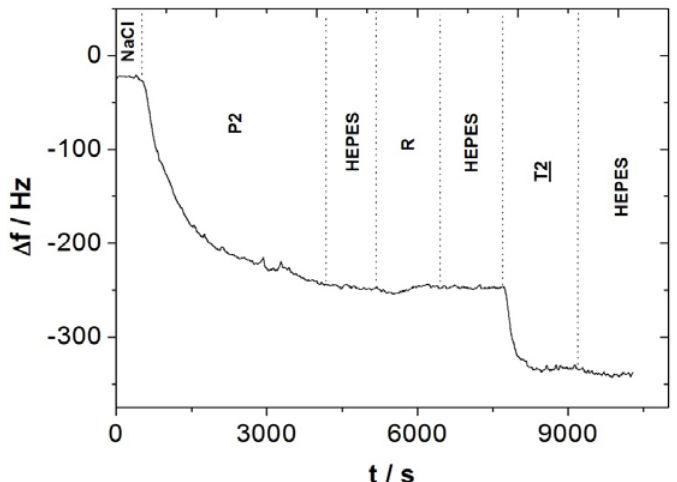
Frequency was monitored during the grafting and hybridization steps (Figure 3). Figure 3. Microbalance frequency kinetics curves of probe (P2) grafting and selective complementary target (T2)